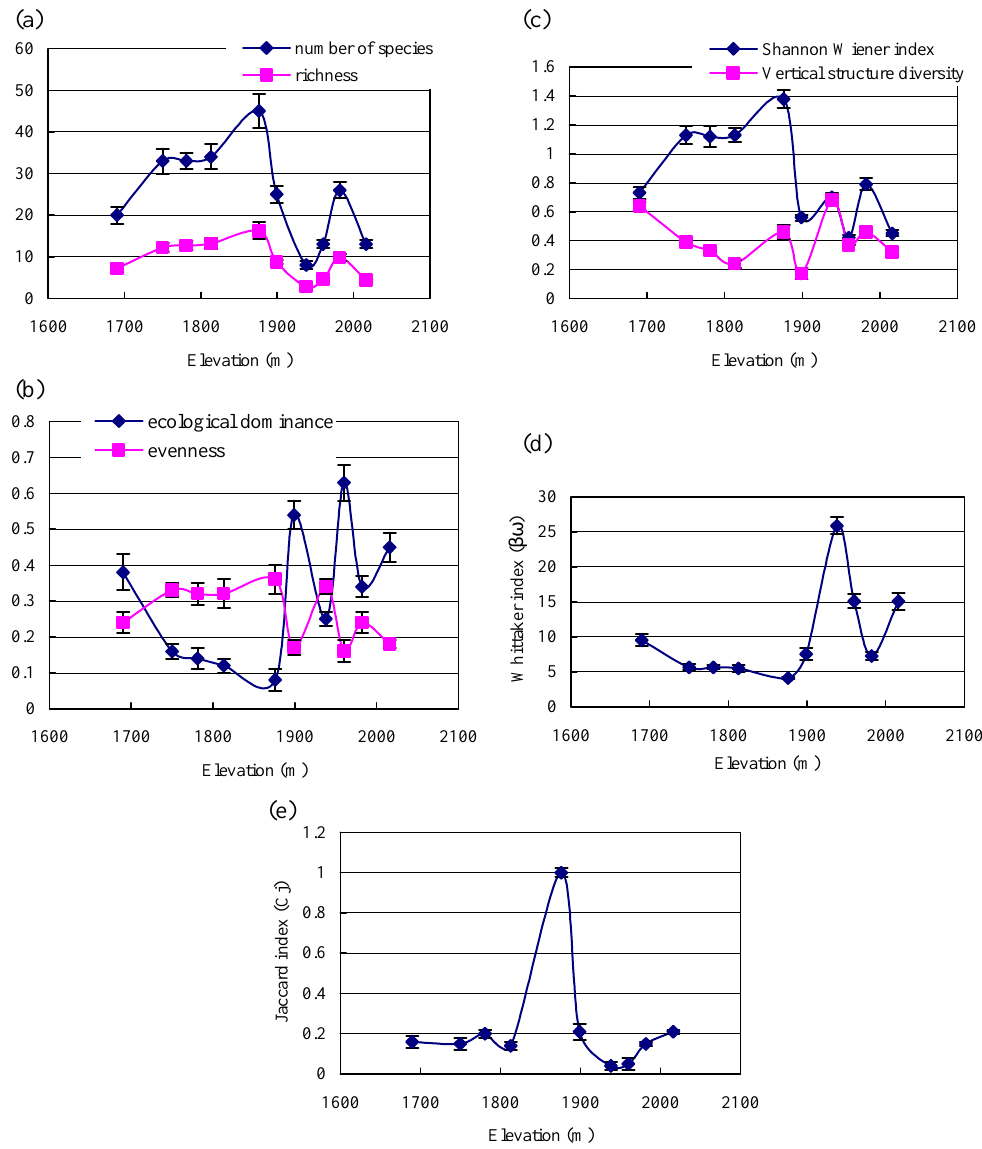
Fig. 2. Values of number species of every community ( N ), species richness (SR), ecological dominance (ED), evenness ( E ), Shannon-Wiener diversity index ( H ’), coverage weighted foliage-height diversity index ( H c ’) and b -diversity ( b v and C j ) for each community with